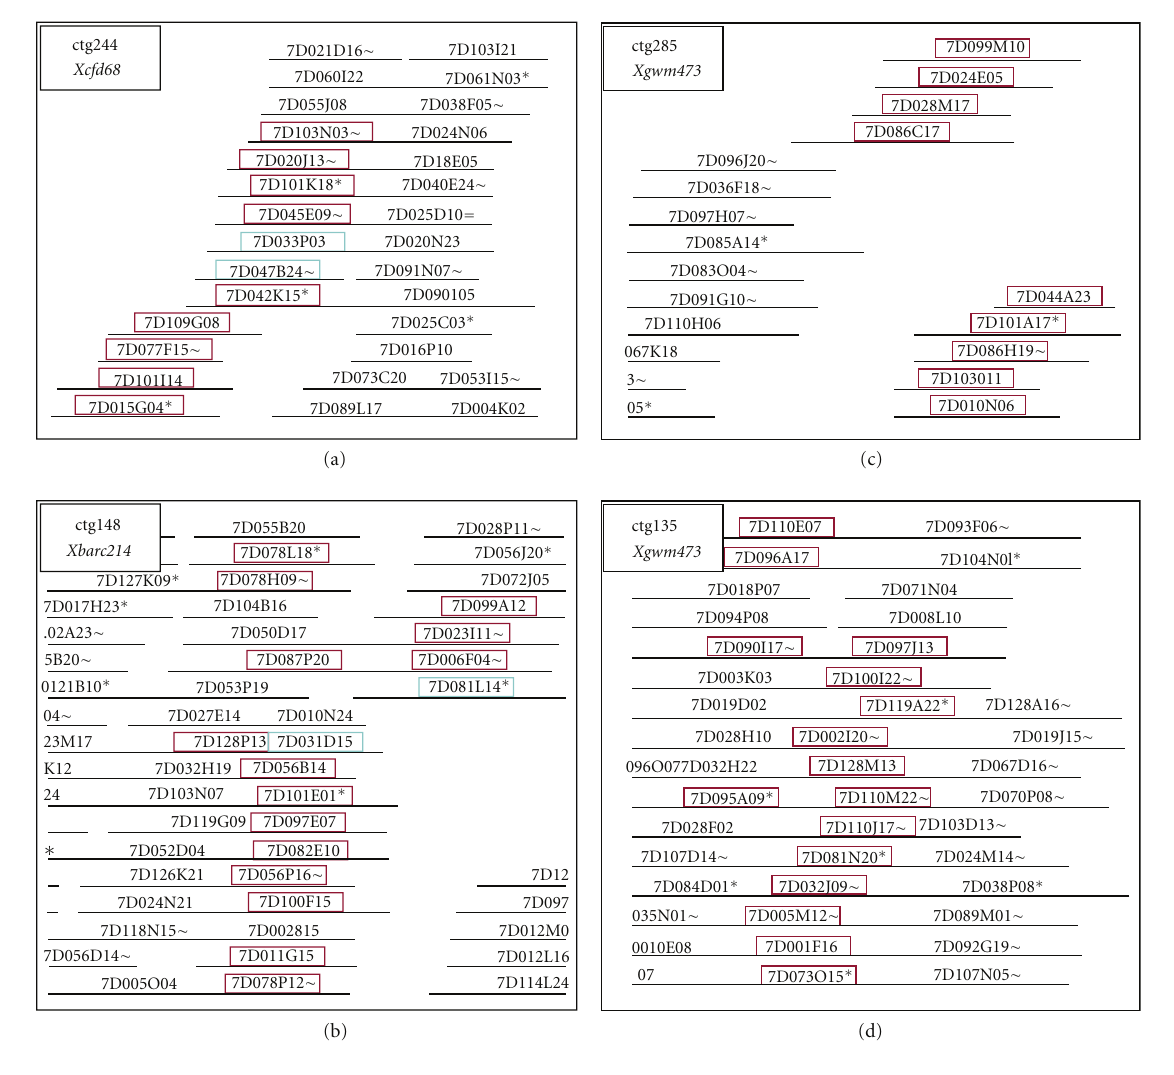
Figure 4: Location of positive BAC clones in BAC contigs. BAC clones positive for Xcfd68 occured in ctg244 (a) and those for Xbarc214 in ctg148. (b) Primers for the Xgwm473 marker targeted BAC clones in two contigs - ctg 285, (c) and ctg135. (d) The hit BAC clones are highlighted in purple, the clones identified with the aid of contig-assembly data are highlighted in